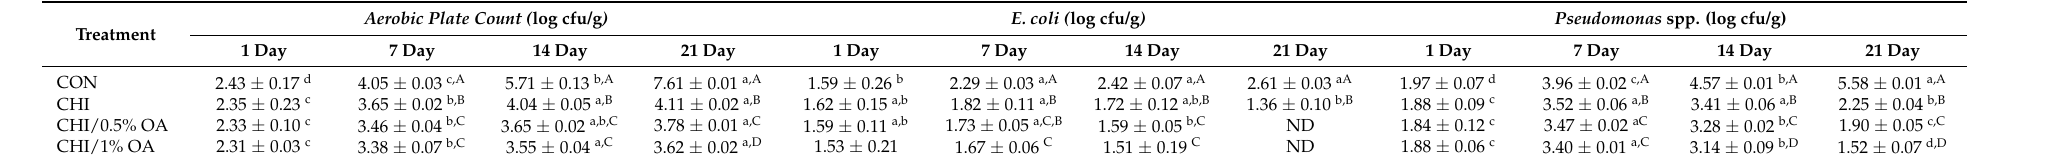
Table 2. Aerobic plate, E. coli and pseudomonas spp. counts of coated pork during storage.